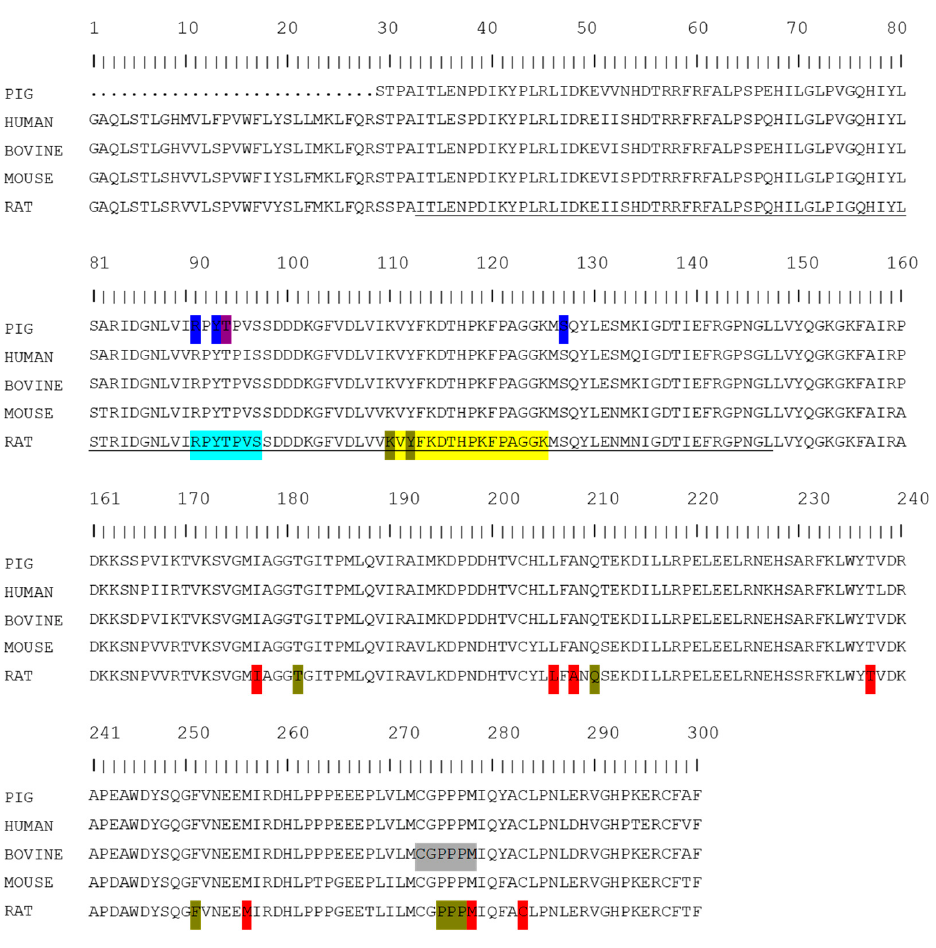
Figure 1. Alignment of C b 5 R isoforms from different sources. Pig (Unitprot: P83686), human (Unitprot: P00387), bovine (Unitprot: P20070) and rat (Unitprot: P20070). Amino acid residues 33–147 located at the amino-terminal side of the FAD-binding domain (underlined sequence); residues 110–125 forming a loop in the FAD-binding domain (yellow background); the conserved motif “91RxYTSxxSN97” (light blue background); location of the R91, Y93, and S127 (dark blue background); location of the T66 of the pig enzyme implicated in the formation and stability of the NAD+–FAD semiquinone complex during NADH turnover which correlate with T94 in the human isoform (purple background); location of the residues forming the plateau where the NAD + group sets and in which the adenine ring and the diphosphate group packed between the side chain residues of these amino acid residues (golden background); Proposed residues that could alter the hydrophobic environment formed by the residues I177, L206, A208, T237, M256, M278, and C283 affecting the binding of NAD + (red background); suggested sequence 273 CGPPPM 278 to be critical for the correct orientation of the nicotinamide moiety with the flavin for efficient hydride transfer (grey background).